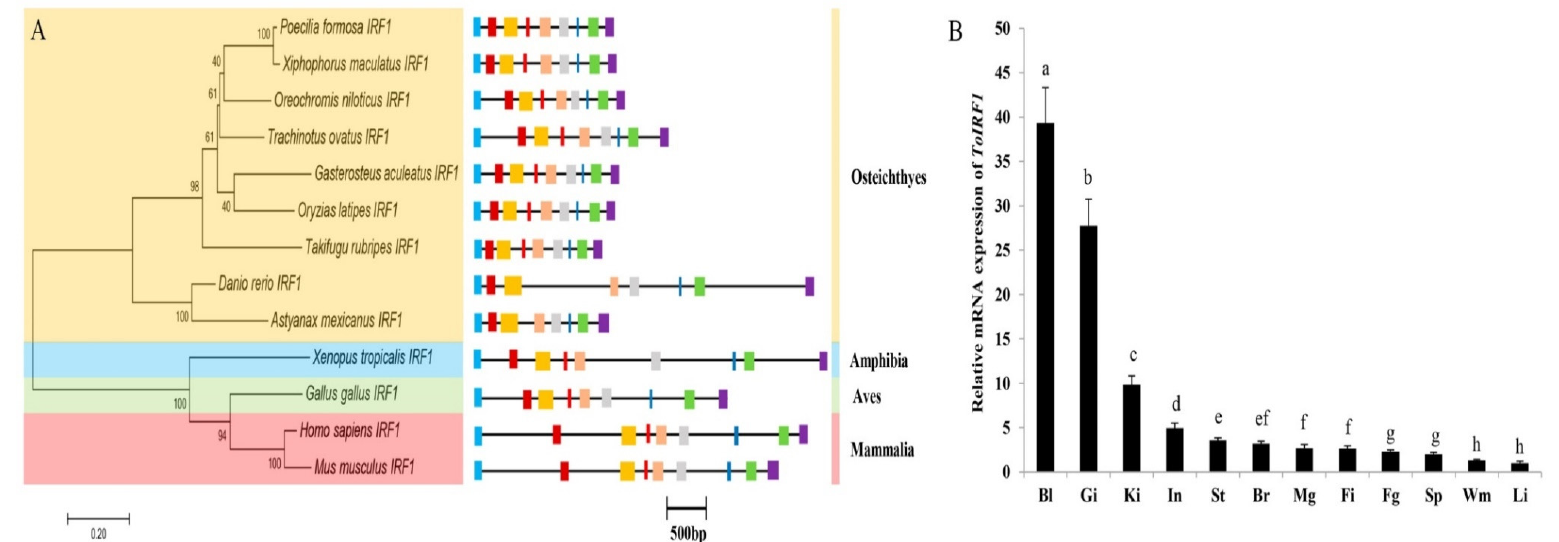
Figure 2. Evolutionary status, structure, and tissue expression of the ToIRF1 gene. ( A ) Genome structure analysis of IRF1 genes according to the phylogenetic relationship. Lengths of exons and introns of each IRF1 gene are displayed proportionally. Different colored boxes and lines represent exons and introns, respectively. The identical colored boxes represent homologous sequences. ( B ) Gene transcription of ToIRF1 in various tissues. The 12 tissues are whole blood (Bl), gill (Gi), head-kidney (Ki), small intestine (In), stomach (St), brain (Br), male gonad (Mg), fin (Fi), female gonad (Fg), spleen (Sp), white muscle (Wm), and liver (Li). Different letters indicate significant differences.